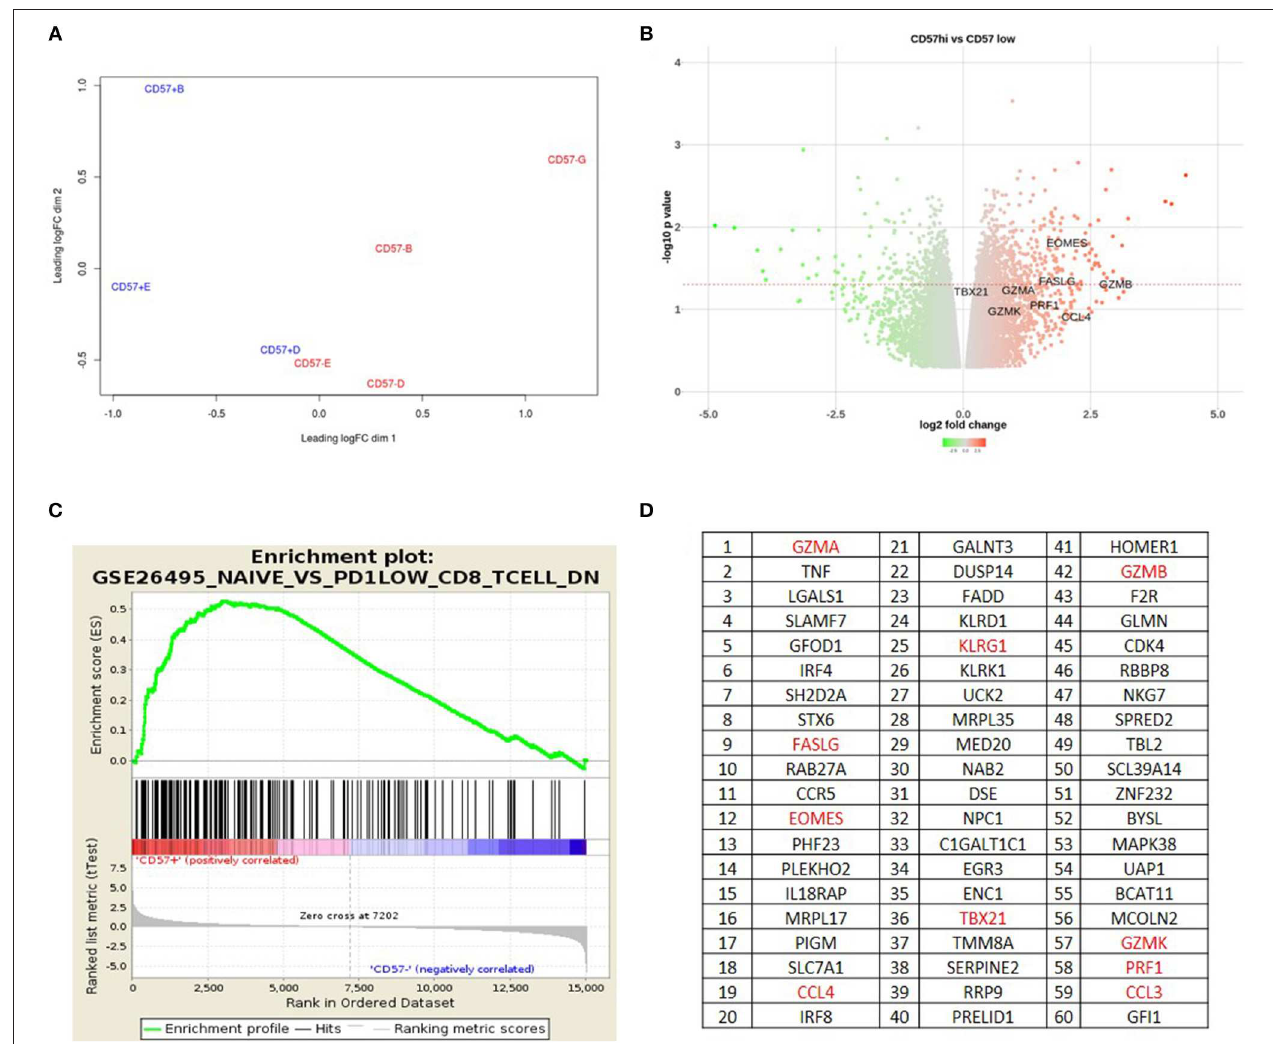
FIGURE 3 | CD57 + CD4 + T cells have a cytolytic transcription profile. (A) Principle Component Analysis. (B) Volcano plot showing over and under-expressed genes in CD4 + CD57 + RO + vs. CD4 + CD57 − RO + . (C) GSEA plot showing CD4 + CD57 + RO + correlating with PD-1 low CD8 + T cells. (D) Leading Edge Analysis showing top 60 genes expressed in CD4 + CD57 + RO +